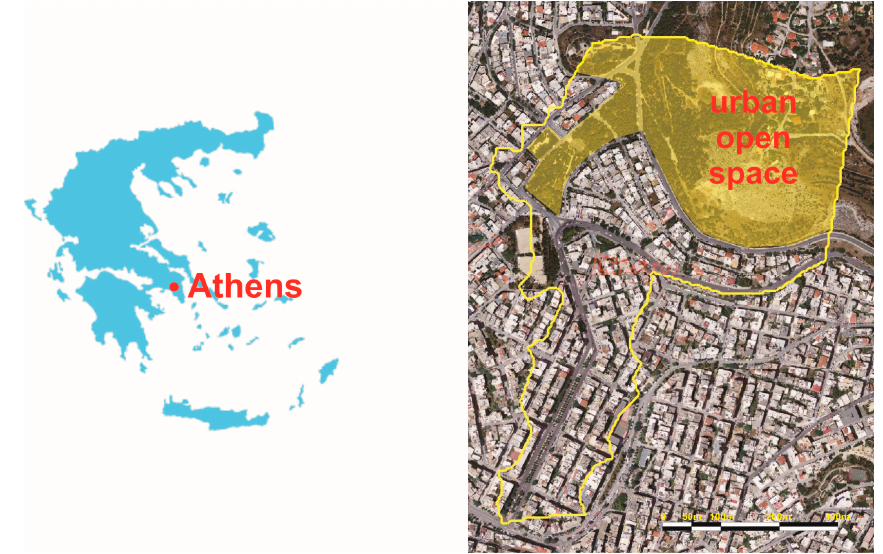
Figure 1. Boundaries of the catchment and location of the open urban space (National Cadastre & Mapping Agency of Greece, Cholargos, Greece, www.ktimatologio.gr). & Mapping Agency of Greece, Cholargos, Greece,